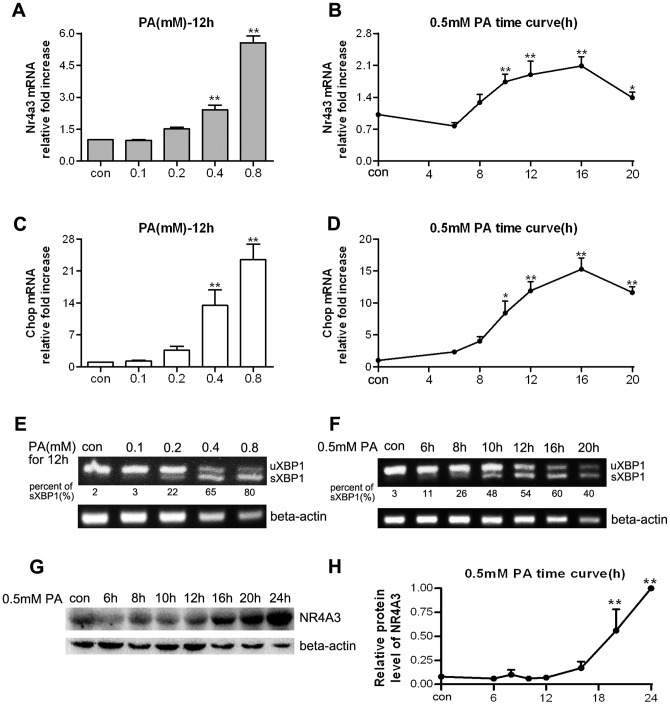
Palmitate (PA) treatment induced NR4A3 expression and unfolded protein response (UPR) activation in MIN6 cells.(A, B) NR4A3 mRNA levels in response to (A) different doses of PA and (B) a fixed PA dose at a series of time points. (C, D) Chop mRNA levels in response to (C) different doses of PA and (D) a fixed PA dose at a series of time points. Relative mRNA levels of NR4A3 and Chop were determined with real-time quantitative PCR. (E, F) Spliced XBP1 (sXBP1) mRNA formation in response to (E) different doses of PA and (F) a fixed PA dose at different time points. Two forms of XBP1 (a UPR molecule) were detected with reverse transcription PCR. (G) NR4A3 protein profile in response to a fixed PA dose at a series of time points assayed with western blotting. (H) Semi-quantitative analyses of NR4A3 protein in response to a fixed PA dose at a series of time points. Data are shown as means ± S.E. (n = 4). * p<0.05, ** p<0.01 vs. con. Con is either (A, C, E) the vehicle (0.5% bovine serum albumin [BSA]) or (B, D, F– H) the average basal level in 0.5% BSA at a series of time points.